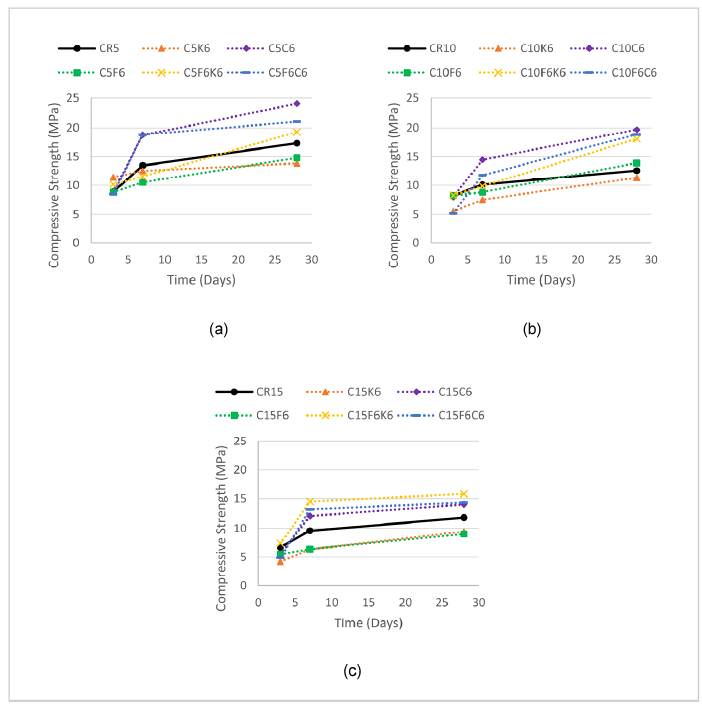
Figure 6. Compressive strength comparison for fiber-reinforced CRM at 3, 7, and 28 days. ( a ) 5% CR replacement. ( b ) 10% CR replacement. ( c ) 15% CR replacement.